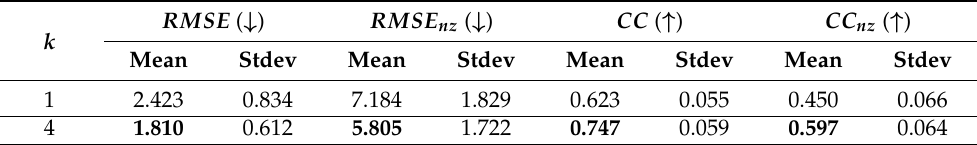
Table 4. The results for the regression evaluation metrics for predicting three time steps in the future using the MET case study, where k denotes the number of previous time steps that were used in the predictions. The means and standard deviations that were computed across the three experimental runs are shown. The best values for the performance metrics are marked with bold.